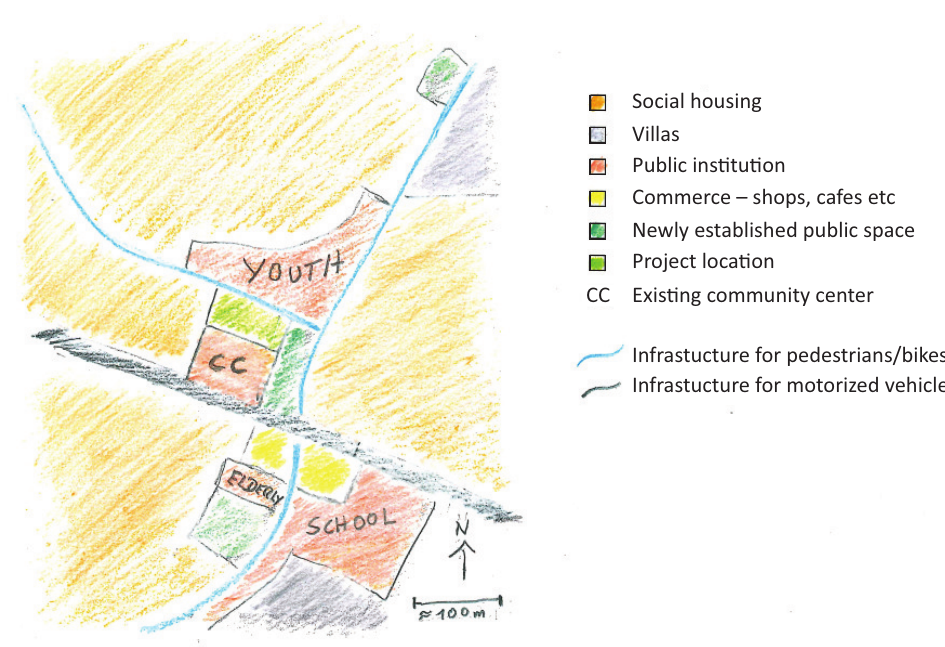
Figure 1. The Lanterna: The project’s location in the district of Aalborg East. existing recreational facilities and a public youth club and will be well connected to previous physical and social interventions. Thus, in line with Latham and Layton’s (2019) arguments on the importance of accessibility and the abundance of successful social infrastructure, the Lanterna will become an easily accessible location for a variety of people from different socio‐economic and demographic backgrounds, including from outside social